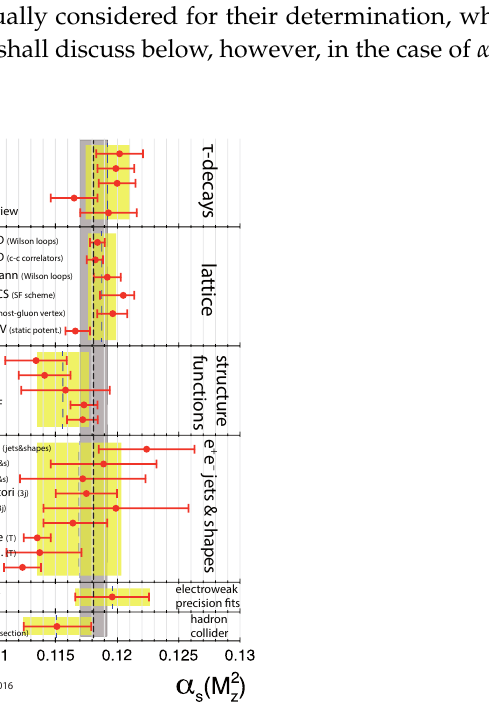
Figure 1. PDG summary of α s -determinations from six chosen sub-fields [3]. The yellow (light shaded) bands and dashed lines indicate the pre-average values of each sub-field. The dotted line and grey (dark shaded) band represent the final world average vale of α s